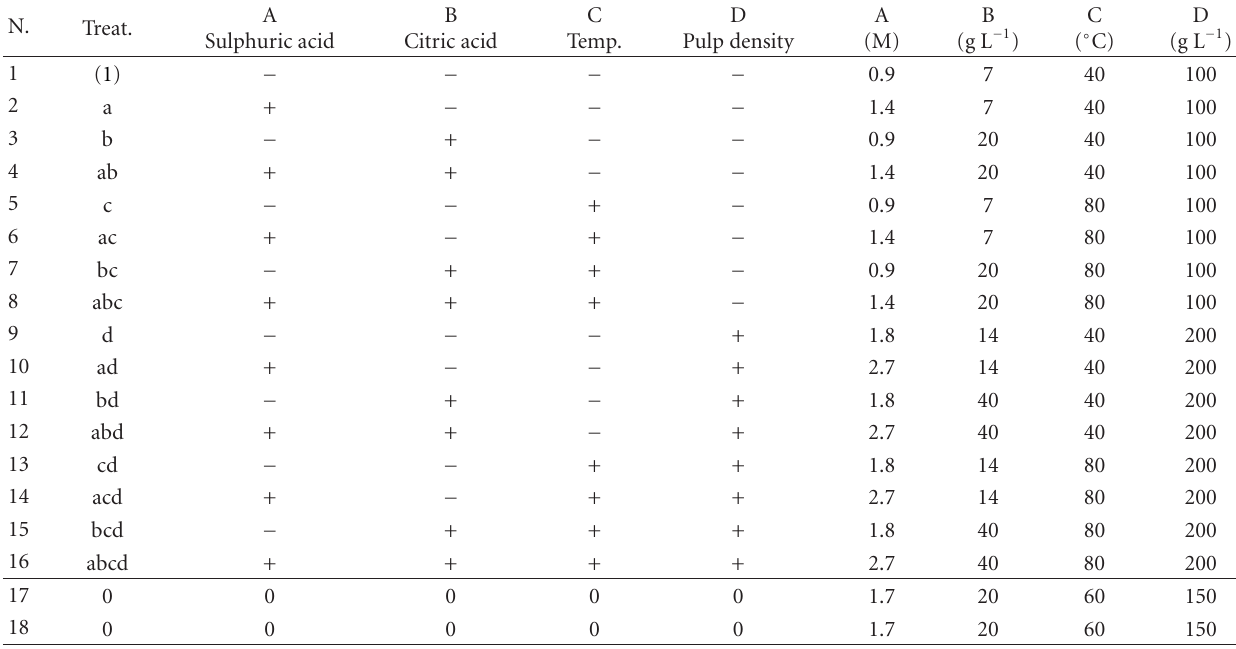
Table 1: Experimental conditions of 2 4 full factorial